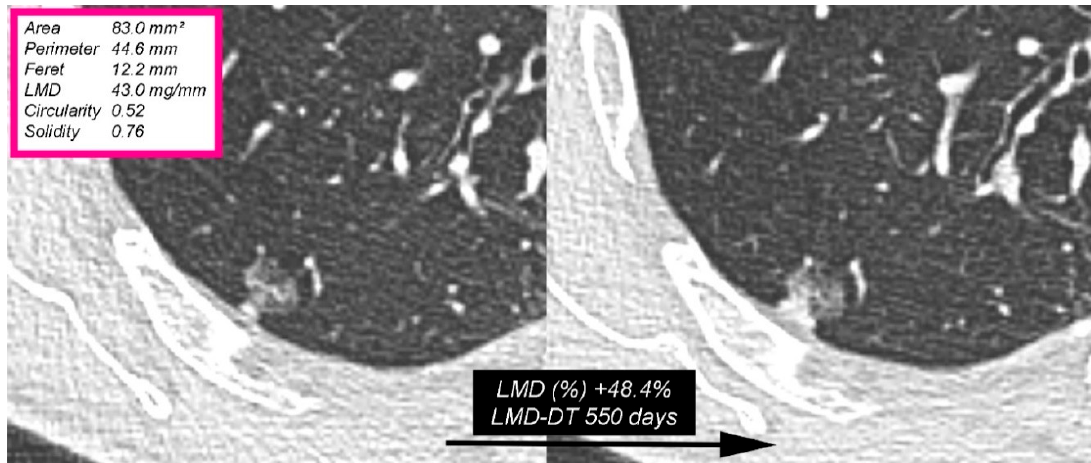
Figure 6. Growing part-solid nodule (PSN) in the right upper lobe in a 78-year-old man with a previous smoking and oncologic history. The PSN exhibits a mushroom shape. The interval between the baseline ( left ) and last follow-up CT scan ( right ) was 313 days. The computerized analysis showed a significant relative linear mass density (LMD) variation of +48.4% in the nodule with an LMD-doubling time (LMD-DT) of 550 days. The purple box (top left) shows the main quantitative features obtained from the baseline CT image.